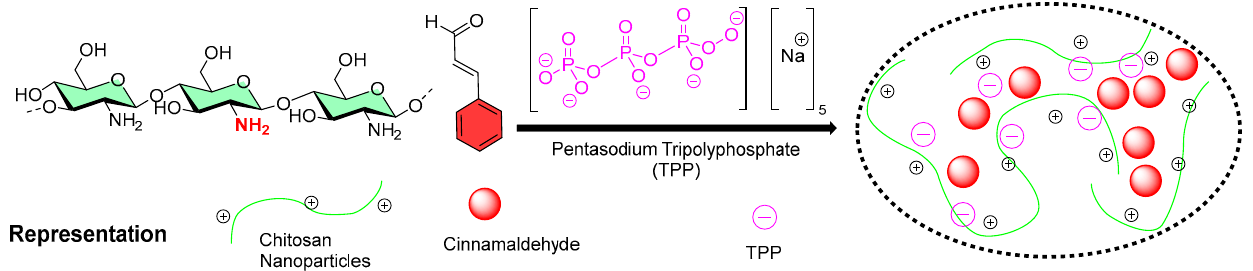
Figure 12. Schematic representation of the preparation of encapsulation of cinnamaldehyde (CA) into CSNPs.